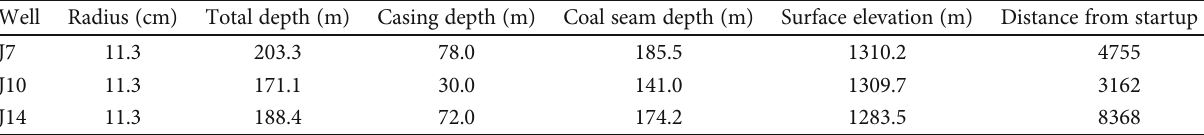
Table 2: Monitored wells in mining areas.